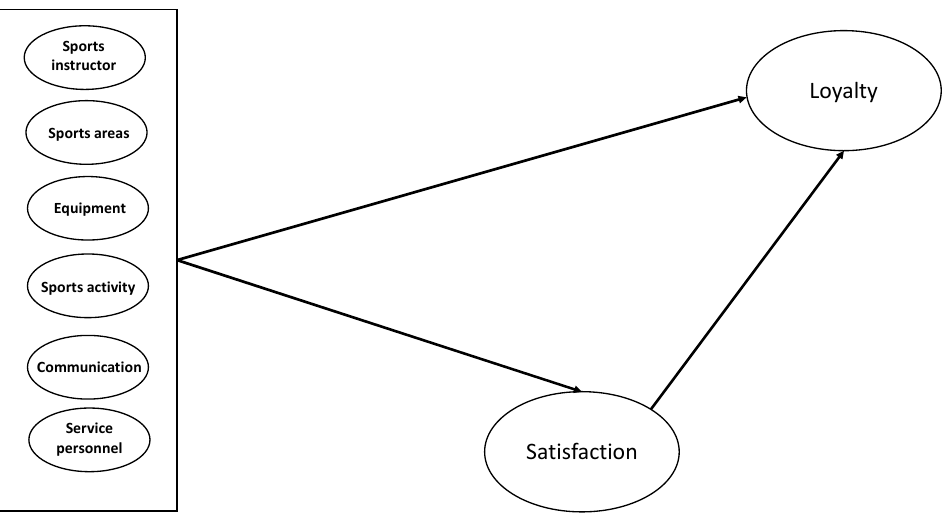
Figure 1. Structural model predicting loyalty to sports and health services among users aged 12–16.